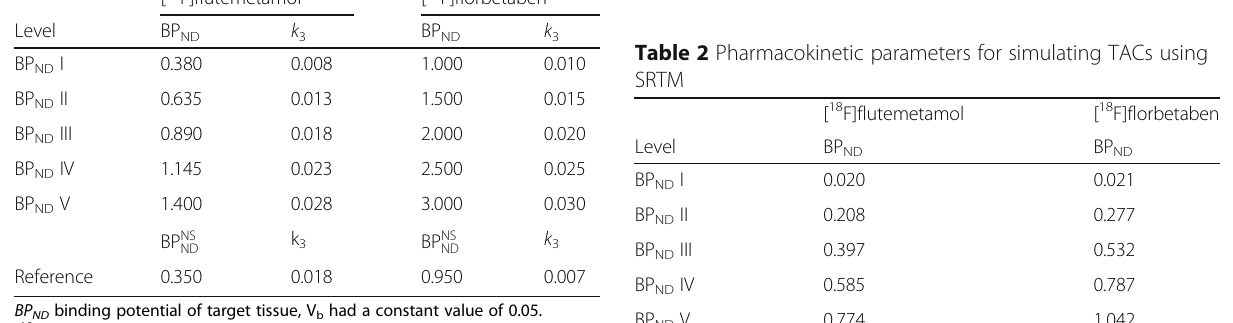
Using SRTM, tissue target TACs of 110 min duration were simulated for the range of BP values observed clinically ND (50 TACs per BP , see Table 2 for kinetic parameters ND used), along the AD continuum. Various levels of typical PET noise were added to these target TACs only (coeffi- cient of variation (COV) of 1, 2, and 5%, respectively) according to the variance model used by Yaqub et al., creating 50 TACs per noise level for each BP [27]: ND